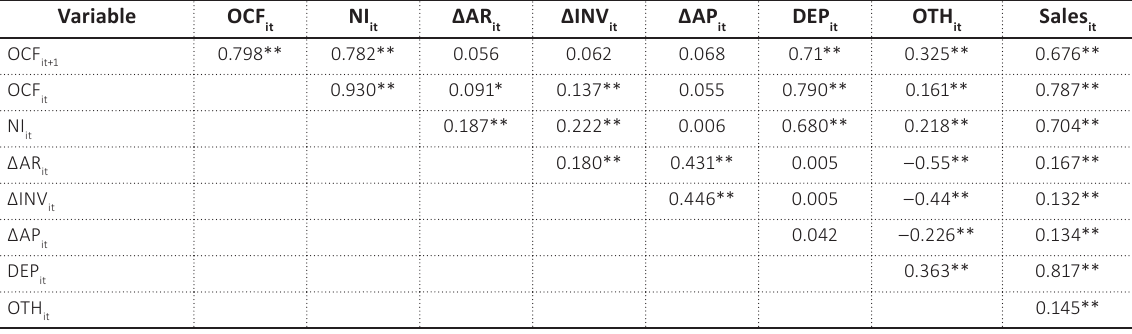
Table 2 indicates a strong and significant relation- ship between current and future cash flow (0.798) and between earnings and future cash flows